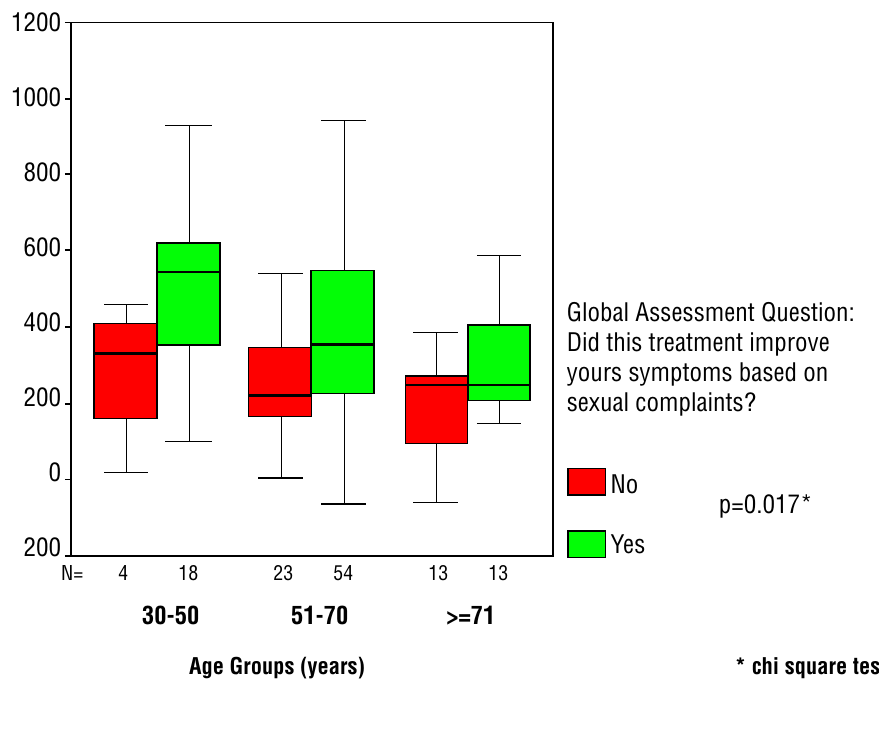
Figure 2 - Increase in Serum Testosterone (3 months after initiation of 25 mg cc) versus Age Groups and Global Assessment